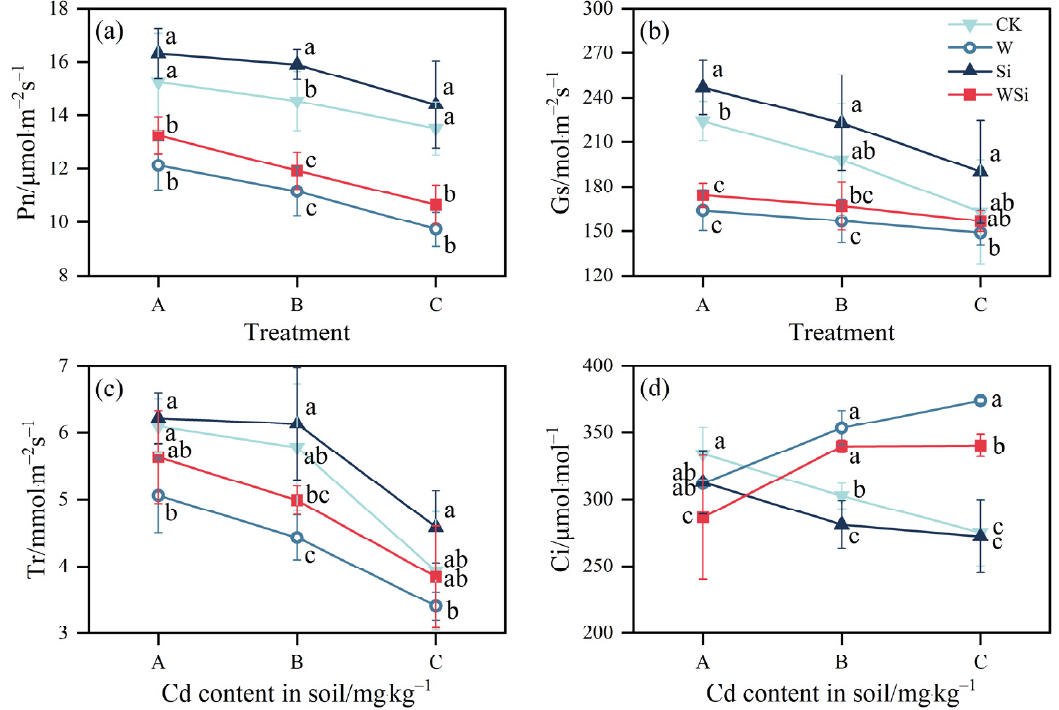
Figure 4. Synergistic effects of water management and silicon foliar spraying on rice photosynthesis (( a ) net photosynthetic rate (Pn); ( b ) stomatal conductance (Gs); ( c ) transpiration rate (Tr); ( d ) intercellular CO 2 concentration (Ci)). The error bar represents three repeated standard deviations (SDs). There is no significant difference between values with the same letters in the table ( p ≥ 0.05, Fisher’s LSD test). A, B and C represent the actual measured Cd content in soil after the addition of exogenous Cd at 0.20 mg·kg − 1 , 0.60 mg·kg − 1 and 1.60 mg·kg − 1 , respectively.